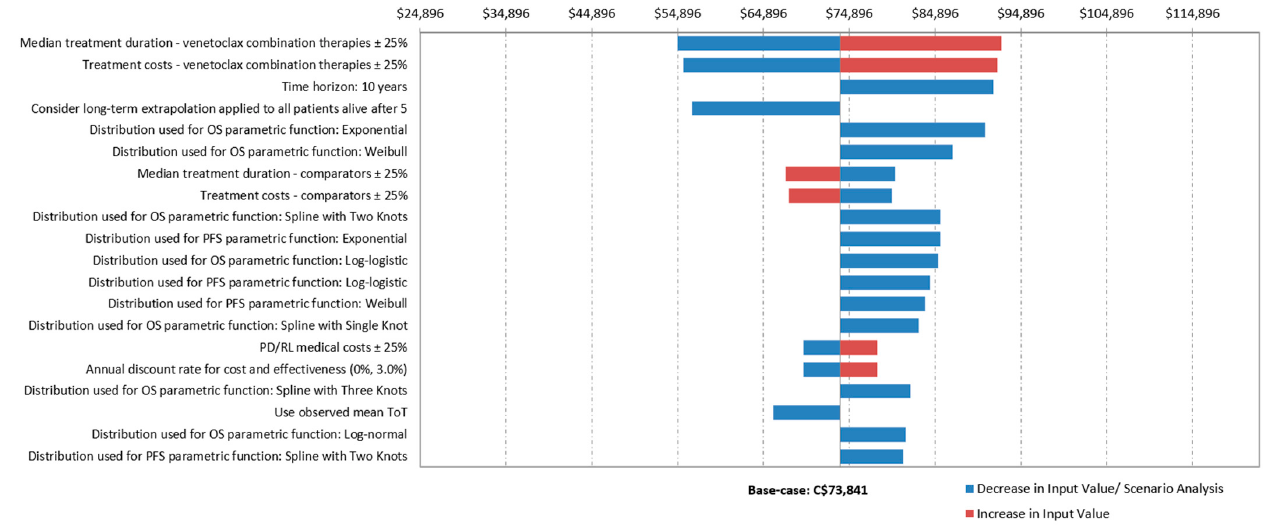
Figure 2. Results of one-way sensitivity analyses from a Ministry of Health perspective. $CA: Cana- dian dollars.